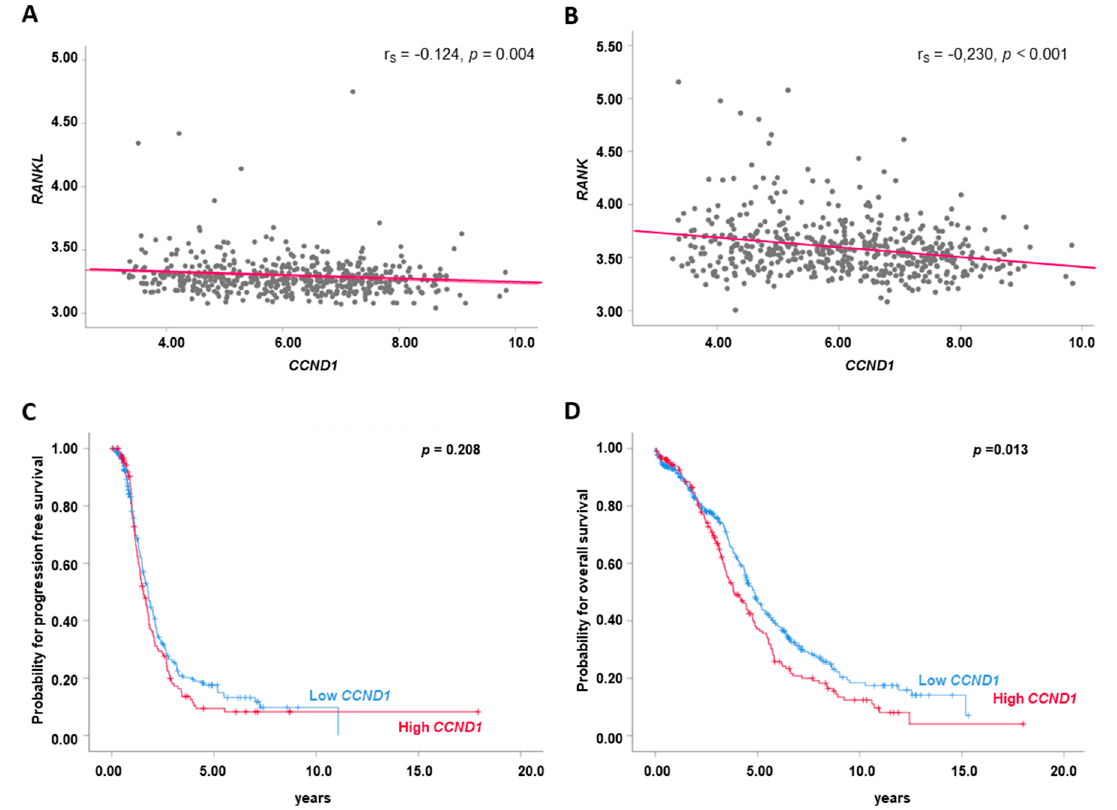
Figure 5. RANK/RANKL correlate with CCND1 which is associated with clinical outcome in the TCGA cohort. Linear regression analysis of ( A ) RANKL and CCND1 , ( B ) RANK and CCND1 in tumour tissue of OC patients ( n = 563). CCND1 ( n = 563) and ( C ) progression free survival and ( D ) overall survival.